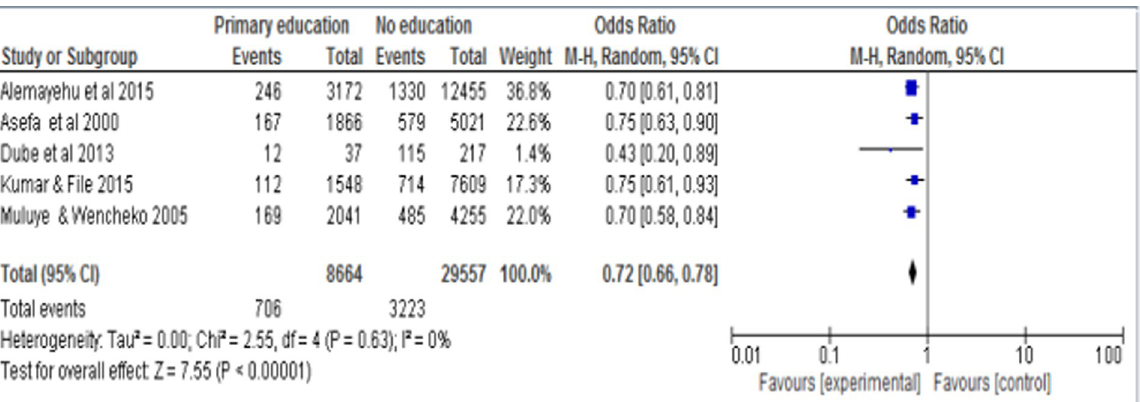
Fig 2. Forest plot of five studies to show the effect of primary maternal education on infant mortality in Ethiopia.